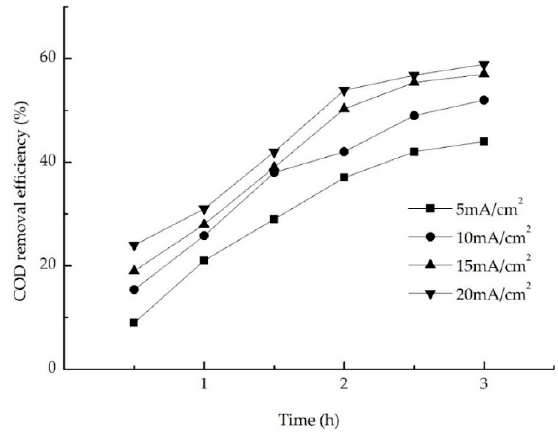
Figure 4. Effect of current density on chemical oxygen demand (COD) removal.